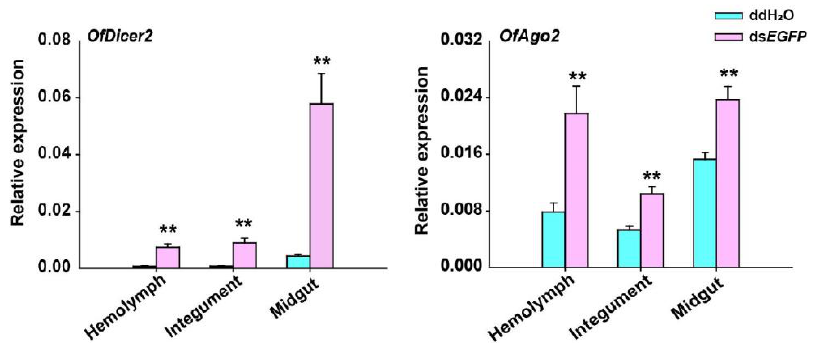
Figure 4. RT-qPCR analyses of relative expression of Dicer2 and Ago2 in different tissues including hemolymph (HE), integument (IN), and midgut (MG) 2 h after injection of ds EGFP . ddH 2 O was injected in the negative control. Each treatment contained five replicates and three individuals were pooled in each replicate. Student ’ s t -test was used in statistical analysis of the data (**, p < 0.01).